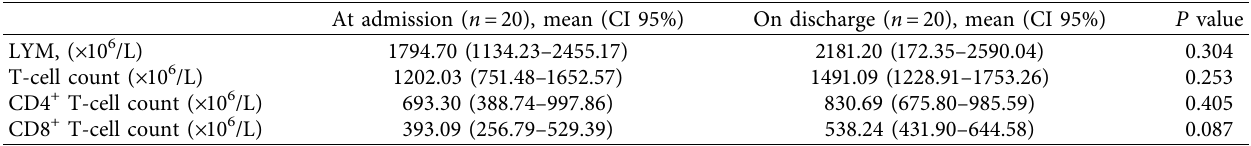
Figure 2: Te NPD of COVID-19 has a linear relationship with lymphocyte count and T-cell subtype. NPD, nucleic acid positive duration. Table 4: Te changes of T-cell subtype of